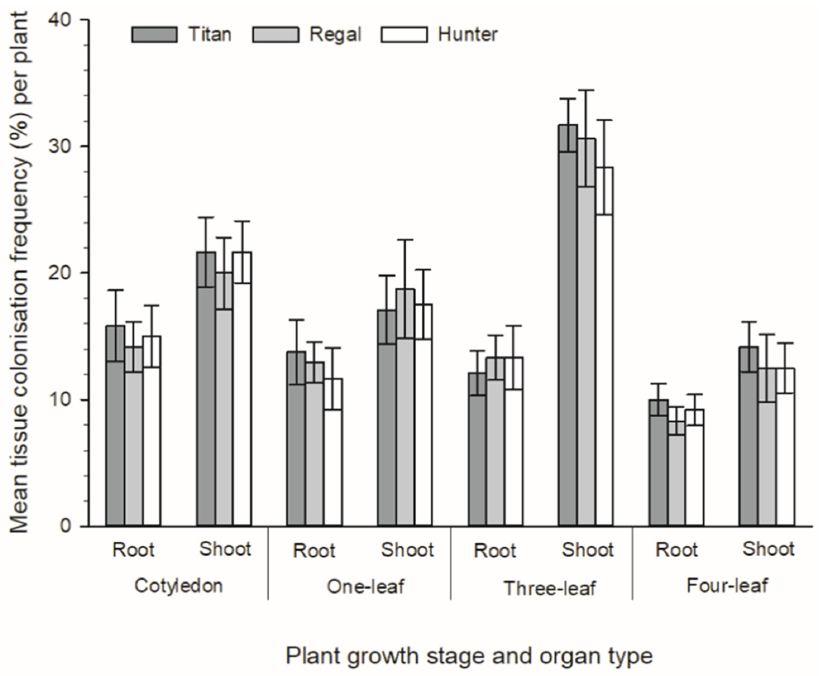
Figure 2. Tissue colonisation frequency (TCF%) of Pseudogymnoascus pannorum O2377 within shoot and root tissues of three forage Brassica cultivars (rape, cv. Titan, kale, cv. Regal and a leafy turnip, cv. Hunter) at four plant growth stages (cotyledon, one-leaf, two-leaf and four-leaf).